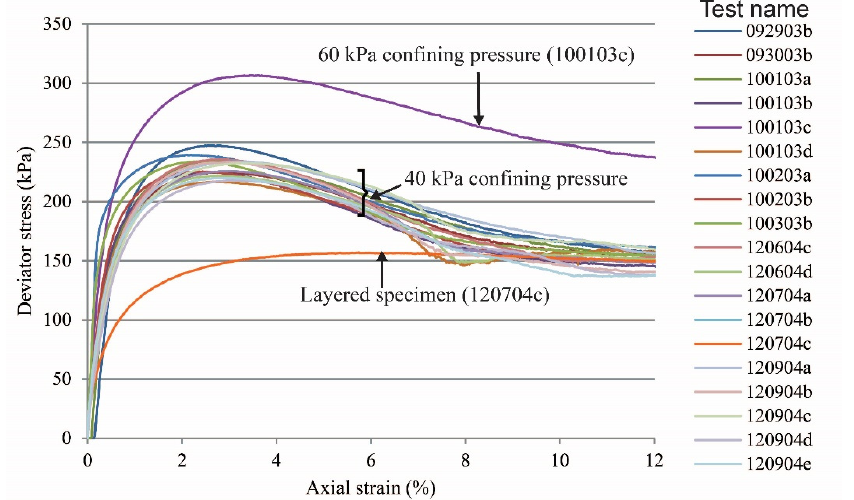
Figure 4. Global stress ‐ strain relations of sand specimens prepared by the dry pluviation method. Mohr’s circles for experiments on all sand specimens are presented in Figures 5 and 6. Failure envelopes and friction angles at the peak strength for dense sand specimens are also shown. A summary of the point of estimates of friction angles versus confining stress for all dense specimens regardless of sample preparation is presented in Figure 7, where the mean and standard deviation of the friction angle for all dense specimens confined at 40 kPa are 47.86 and 1.81, respectively. Figure 5 . Mohr’s circles of sand specimens prepared by the vibratory compaction method.